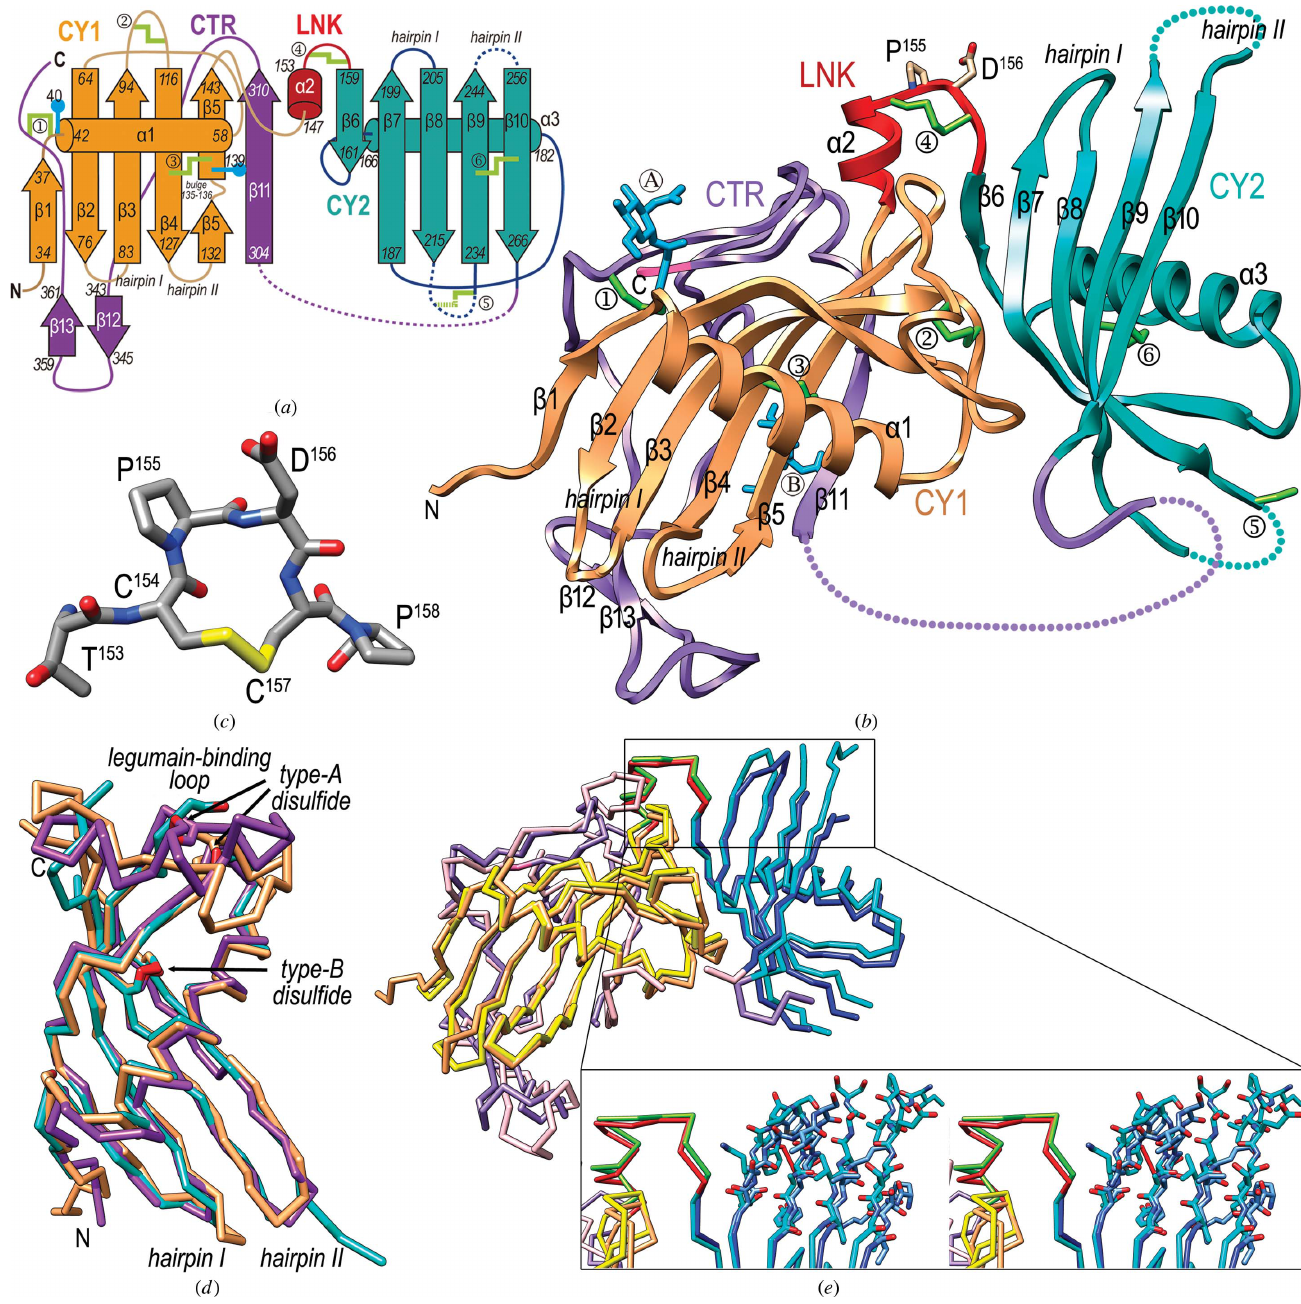
Figure 1 Structure of fetuin-B. ( a ) Topology scheme of mouse fetuin-B depicting strands as arrows (labeled (cid:3) 1– (cid:3) 13) and helices as rods ( (cid:2) 1– (cid:2) 3), each with their delimiting residues. Domain CY1 is in orange, the linker (LNK) is in red, CY2 is in turquoise and the CTR is in purple. N-glycans are marked with blue lollipops and labeled. Disulfides are pinpointed as pale green lines and labeled: (cid:6) 1 , C 39 –C 374 ; (cid:6) 2 , C 96 –C 107 ; (cid:6) 3 , C 120 –C 140 ; (cid:6) 4 , C 154 –C 157 ; (cid:6) 5 , C 217 –C 224 ; (cid:6) 6 , C 237 –C 263 . Missing segments are shown as dotted lines, and hairpins I and II of each cystatin domain are further labeled. ( b ) Ribbon-type plot of mouse fetuin-B, with each domain colored as in ( a ). N-glycans are labeled with an encircled ‘A’ (N 40 ) and ‘B’ (N 139 ); P 155 and N 156 from the CPDCP-trunk are labeled and their side chains are shown. The N- and the C-termini of the protein are labeled and residues from the purification tag are shown in pink. ( c ) The CPDCP-trunk featuring a rigid 14-atom ring (C atoms in gray). ( d ) Superposition of CY1 (orange), CY2 (cyan) and ovocystatin (purple; PDB entry 1cew; Bode et al. , 1988) as C (cid:2) plots. The respective type-A and type B-disulfides are shown in red and labeled, as are the legumain-binding loops in the three structures, hairpins I and II, and the N- and C-termini. ( e ) Superposition of the C (cid:2) traces of mouse fetuin-B: unbound (CY1 in yellow, LNK in green, CY2 in dark blue and CTR in pink) and in complex with astacin [domain colors as in ( b )]. The inset shows a close-up showing the CPDCP-trunk, hairpin I and hairpin II in cross-eyed stereo. The observed differences may be authentic or may be the result of crystal